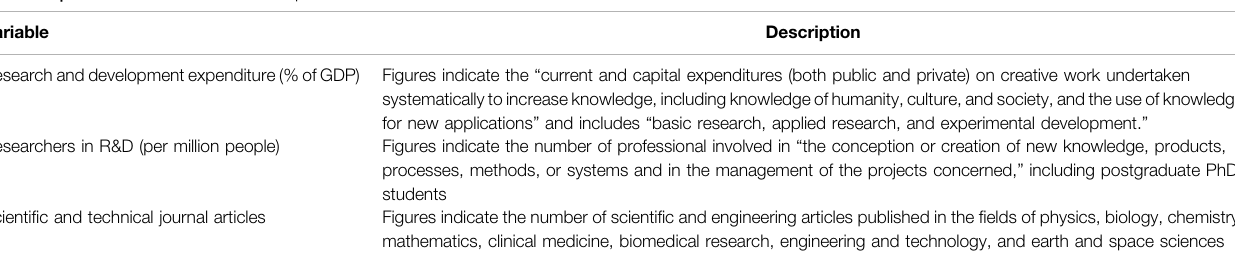
TABLE 2 | Scienti fi c culture variables adapted from the World Bank. Variable